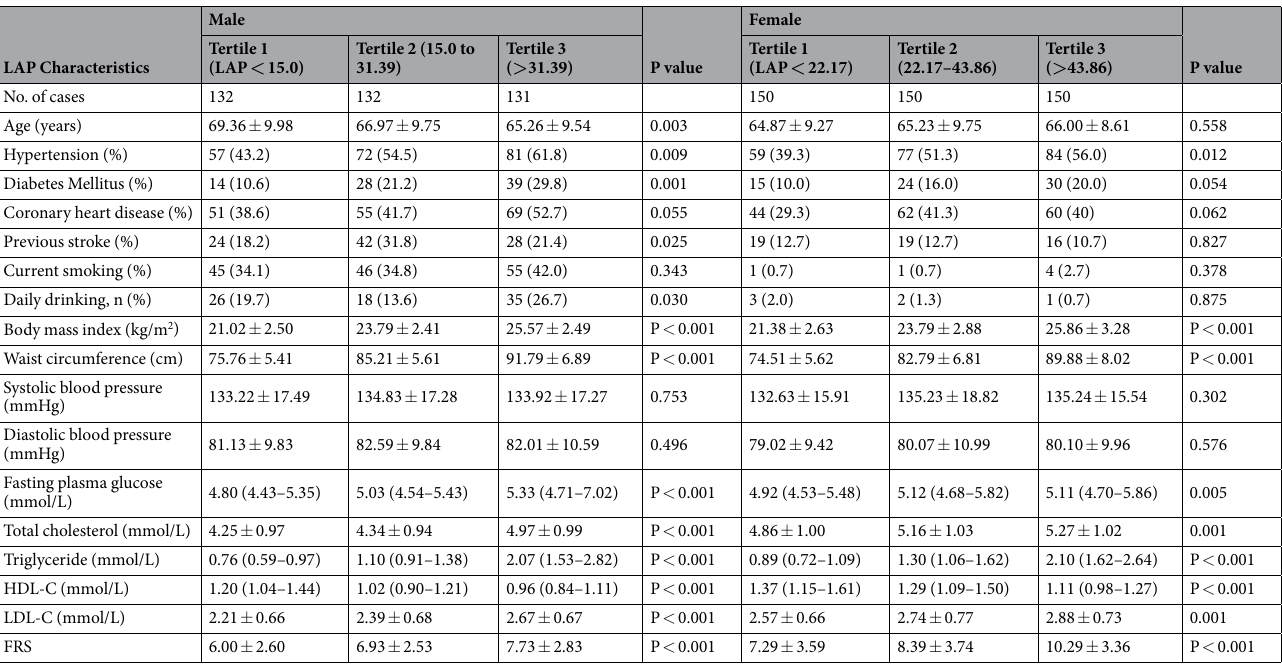
Table 2. Characteristics of patients stratified by LAP tertiles. Continuous variables were analysed with one-way analysis of variance or the Kruskal-Wallis test, and categorical variables were analysed with the chi-square test or Fisher’s exact test. Results are expressed as mean ± SD for variables with a normal distribution, as median and interquartile range for variables with a skewed distribution, or as number with percentage for categorical variables. SD, standard deviation; HDL-C, high density lipoprotein cholesterol; LDL-C, low density lipoprotein cholesterol; LAP, lipid accumulation product; FRS, Framingham risk